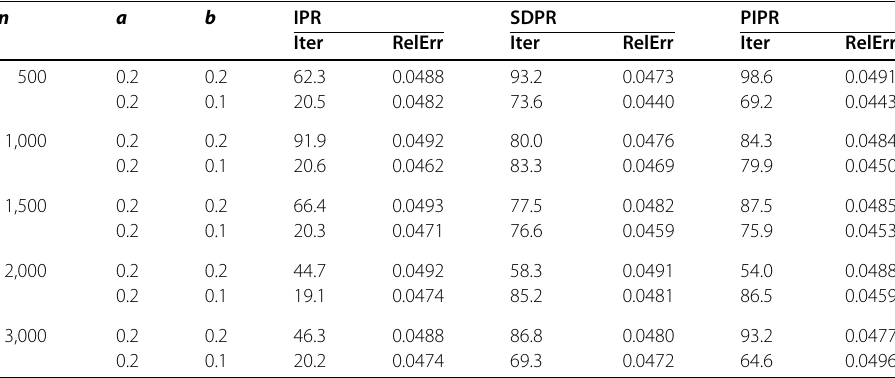
Table 2 Comparison of PALM-IPR with PALM-SDPR and PALM-PIPR